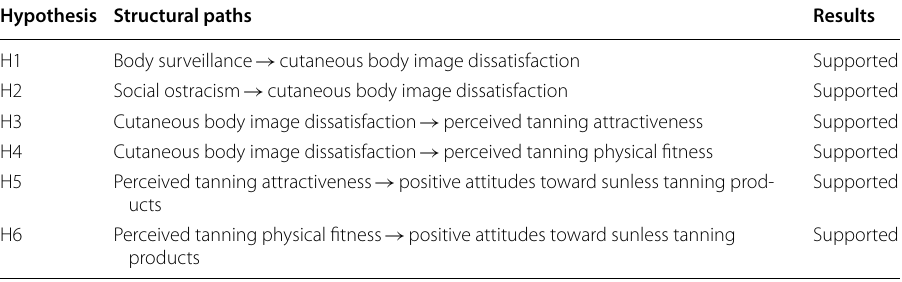
Table 2 Results of the structural equation model Hypothesis Structural